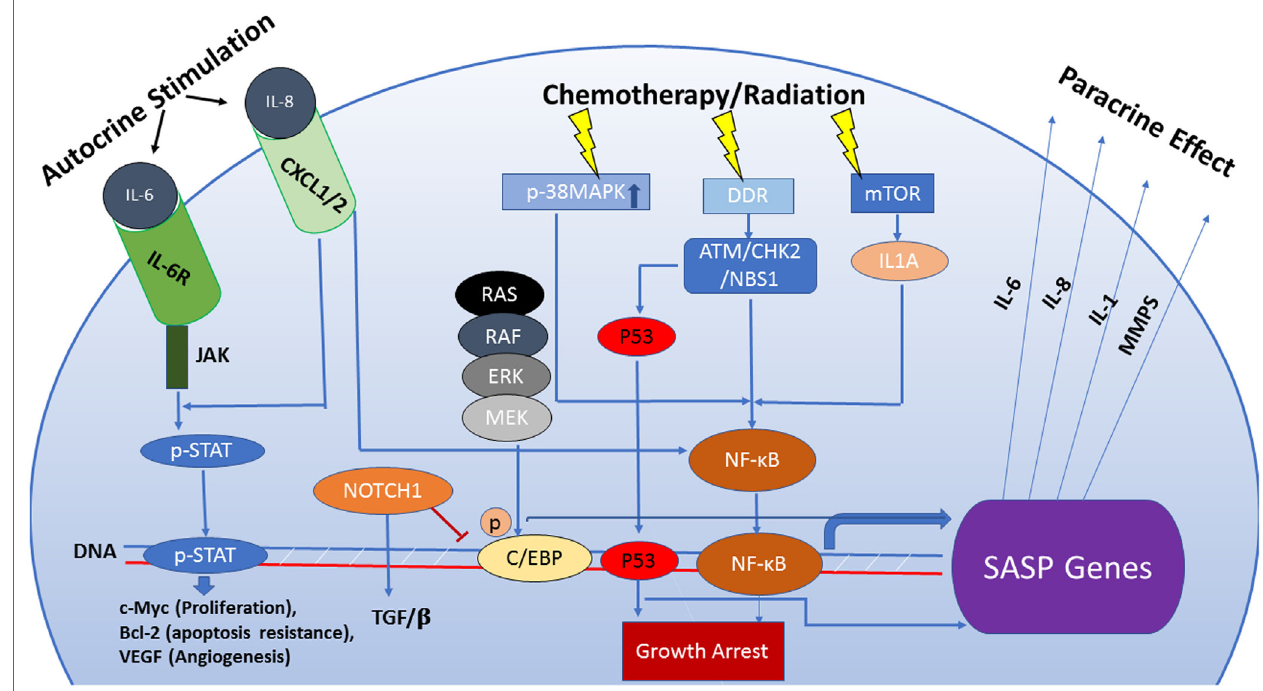
FiGURe 1 | The senescence-associated secretory phenotype (SASP) is regulated by an interactive network of pathways that dictate its functional outcome. Persistent DNA damage can be responsible for activation of the SASP by a mechanism that is independent of cell cycle regulation. Also, the SASP can be induced via pathways separate from the DNA damage response (DDR) such as activation of p38MAPK or mTOR which, in turn, enhance transcriptional activity of NF- к B. Increased transcription of SASP genes is predominantly regulated by the transcription factors NF- к B and C/EBP β . The composition of the SASP is regulated by genotoxic stress pathways, mainly the p53 tumor suppressor pathway. p53 attenuates the SASP through regulation of NF- к B function but can also directly influence the transcription of SASP genes qualitatively, facilitating immune clearance of senescent cells. NOTCH1 signaling modulates the secretome of senescent cells by inhibiting C/EBP β , thus suppressing pro-inflammatory secretion in favor of a TGF- β -rich composition. This switch prevents recruitment of the immune cells to the tumor site. Components of the SASP act as signaling molecules in both paracrine and autocrine fashion and are capable of stimulating complex and sometimes conflicting pathways including senescence maintenance or escape, immune system activation or suppression, induction of tumorigenesis or tumor suppression in neighboring